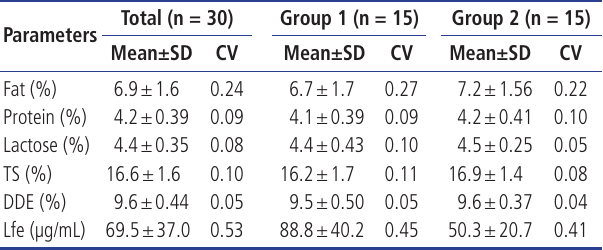
Table 1. Means, standard deviations and coefficient of variation of the biochemical constitution of Murrah buffalo milk in relation to total sample and in groups: beginning of lactation (1) and end of lactation